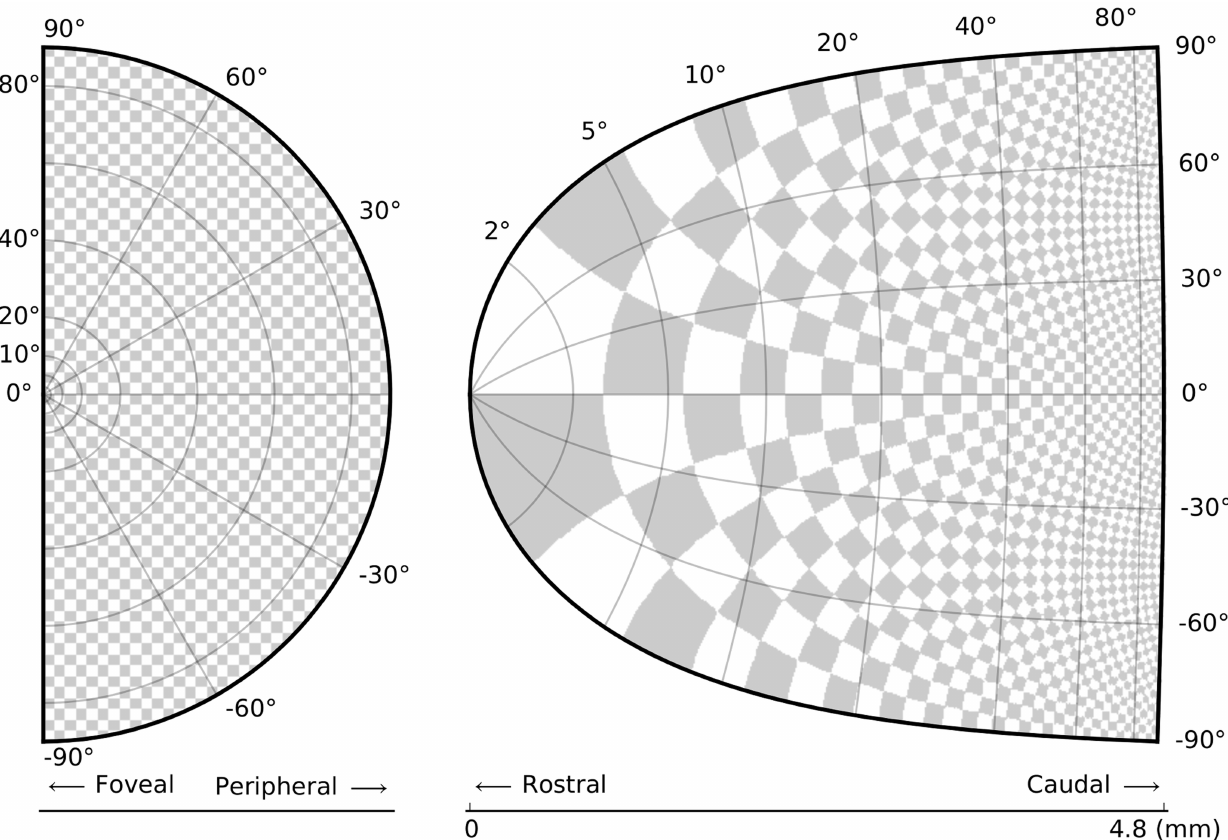
Figure 2. Identify your message. The superior colliculus (SC) is a brainstem structure at the crossroads of multiple functional pathways. Several neurophysiological studies suggest that the population of active neurons in the SC encodes the location of a visual target that induces saccadic eye movement. The projection from the retina surface (on the left) to the collicular surface (on the right) is based on a standard and quantitative model in which a logarithmic mapping function ensures the projection from retinal coordinates to collicular coordinates. This logarithmic mapping plays a major role in saccade decision. To better illustrate this role, an artificial checkerboard pattern has been used, even though such a pattern is not used during experiments. This checkerboard pattern clearly demonstrates the extreme magnification of the foveal region, which is the main message of the figure.